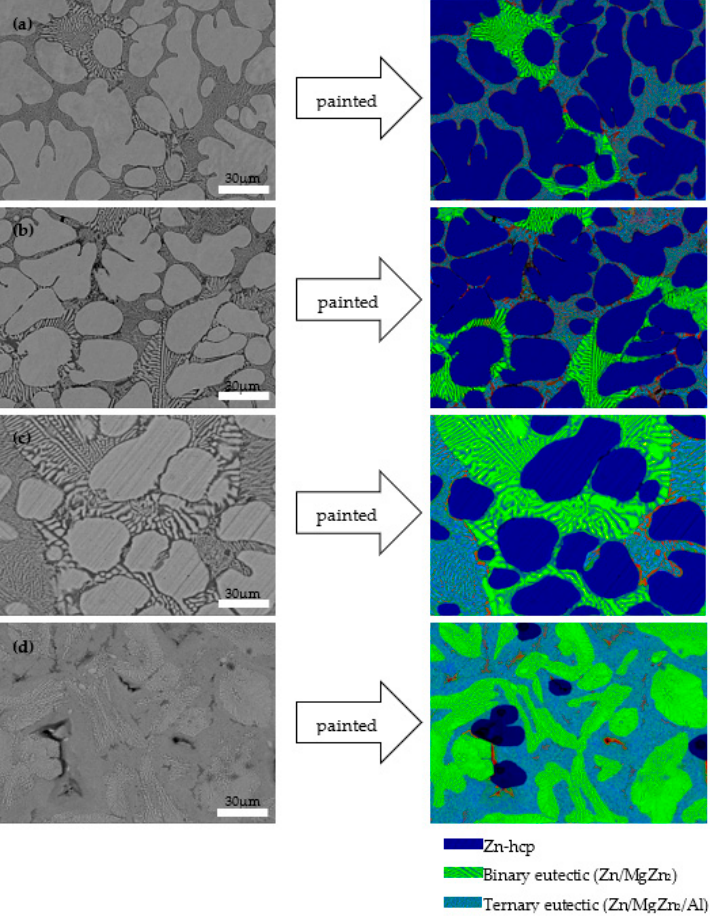
Figure 5. SEM photos of surface, and ImageJ alloy phase dyeing photos of ( a ) Zn-1.0Al-1.0Mg, ( b )